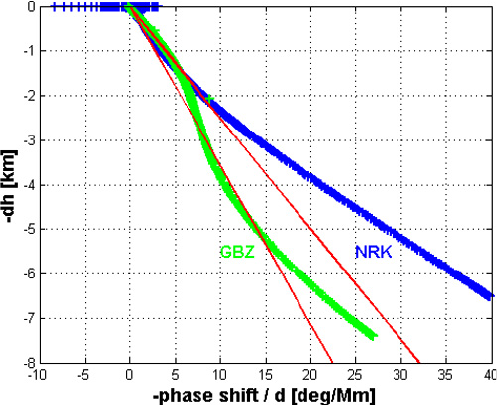
Fig. 9. Height decrease vs. phase shift per Mm. See Sect.